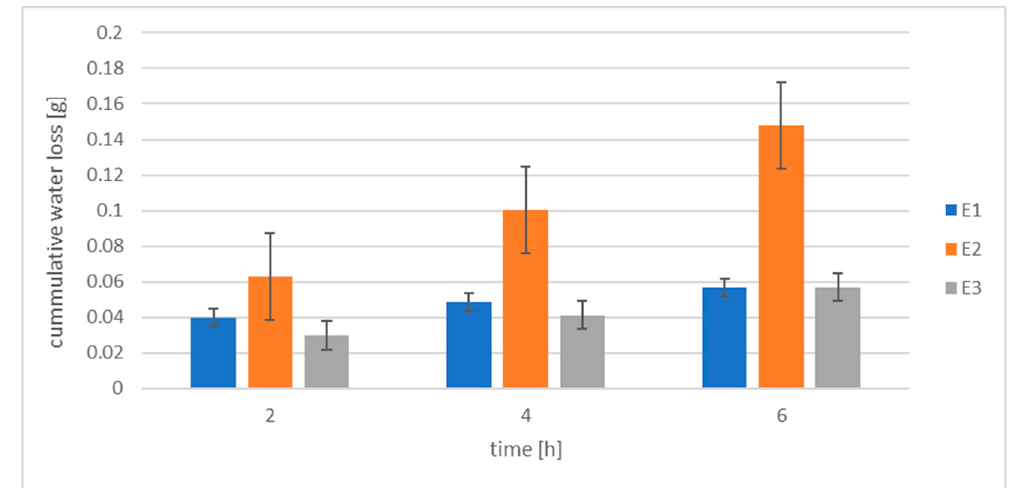
Figure 12. Change of cumulative water loss for analyzed samples E1–E3 after 2, 4, and 6 h, established by Payne Cup method.